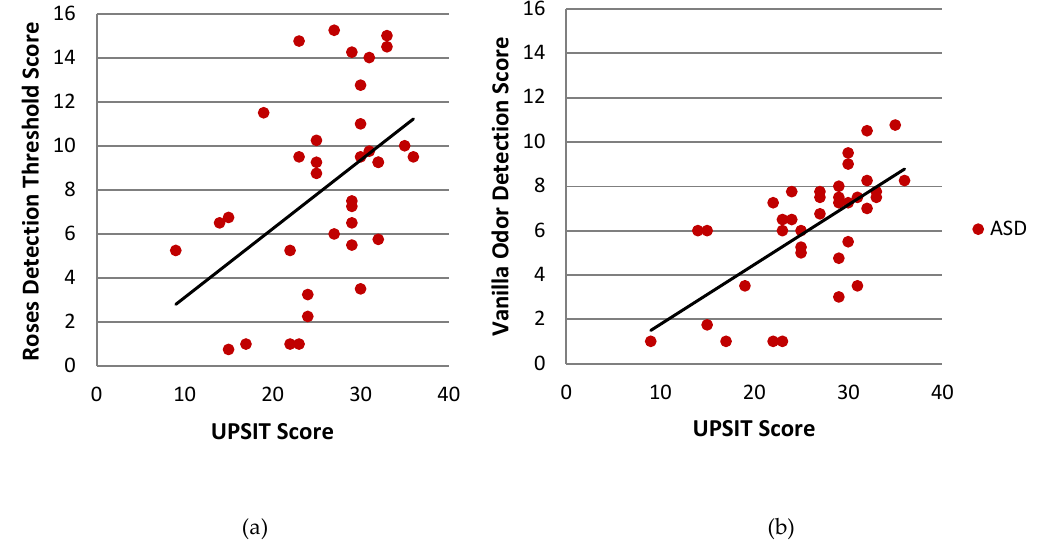
Figure 5. Correlation between smell identification (UPSIT Score) and Sniffin’ Sticks Threshold Test in the ASD group. Sniffin’ Sticks odor detection threshold scores are displayed for the Roses odor (a) and Vanilla odor (b). Each point represents one individual. UPSIT = University of Pennsylvania Smell Identification Test; ASD = children with Autism Spectrum Disorder.